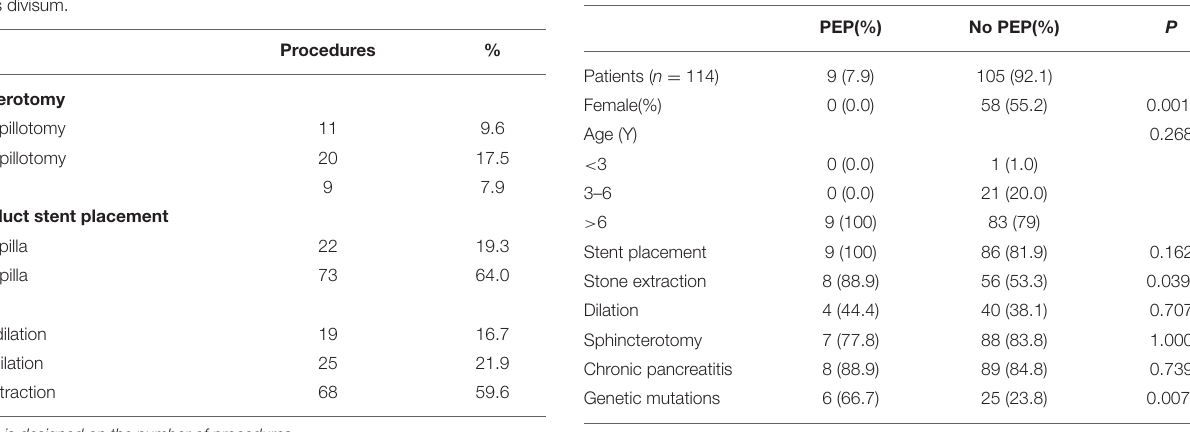
TABLE 5 | Univariate analysis of factors associated with PEP development.